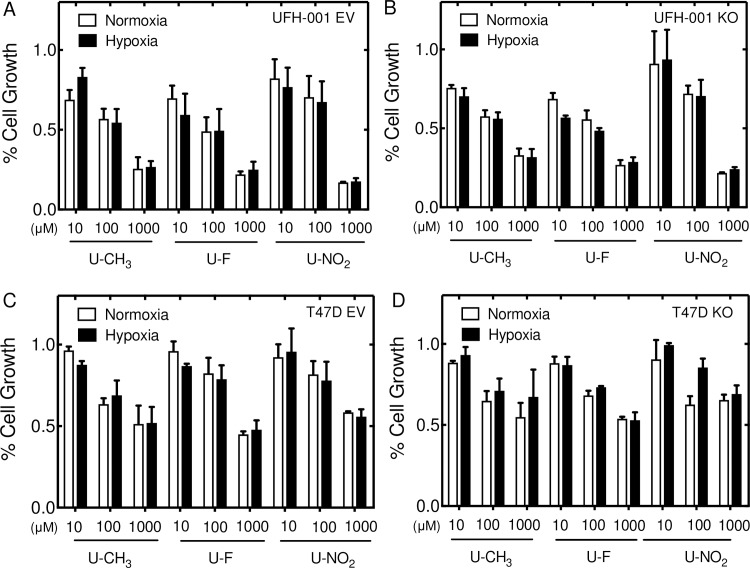
Effects of USBs on cell growth in the presence or absence of hypoxia or in CA knockout cells.One day after plating, breast cancer cell lines were exposed to normoxic or hypoxic conditions for 48 h in the presence of U-CH3, U-F, or U-NO2 at the given concentrations in UFH-001 empty vector control (EV) cells (Panel A), UFH-001 CA IX KO (UFH-001 KO) cells (Panel B), T47D EV cells (Panel C) and T47D CA XII KO (T47D KO) cells (Panel D). MTT assay was performed and shown as % cell growth. Data shown represent at least three independent experiments and are shown as the mean ± SEM.